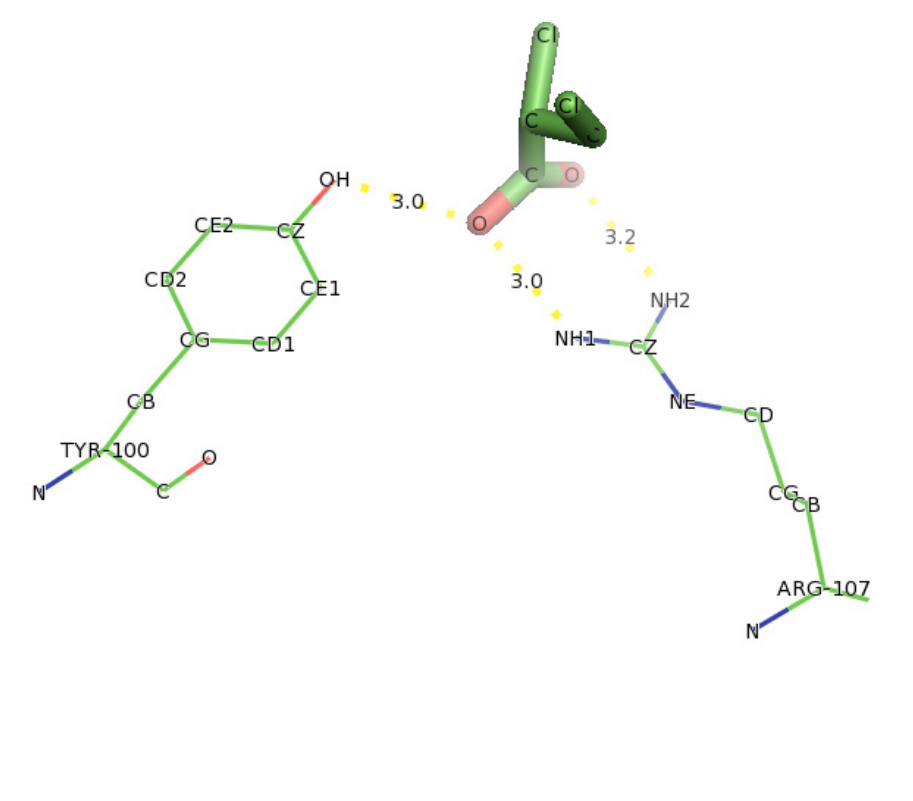
Figure 20. The interacting residues of DehD with D,L -2,3-DCP. Hydrogen bond distances are in